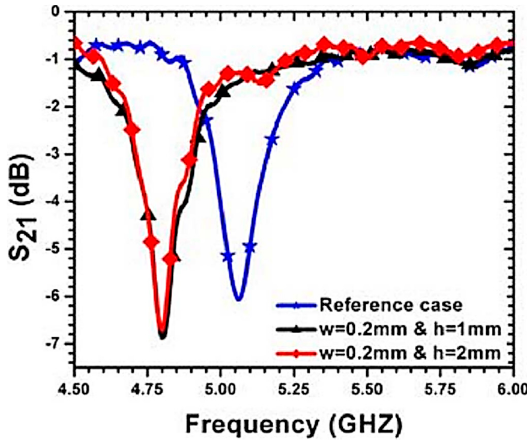
Figure 15. Minimum transmission of the sensor for a crack width ( w ) of 200 μ m as compared to solid aluminum. For Case 1, the crack depth ( h ) is 200 μ m. For Case 2, the crack depth ( h ) is 100 μ m (from [38]; copyright © IEEE 2012; reproduced with permission.)